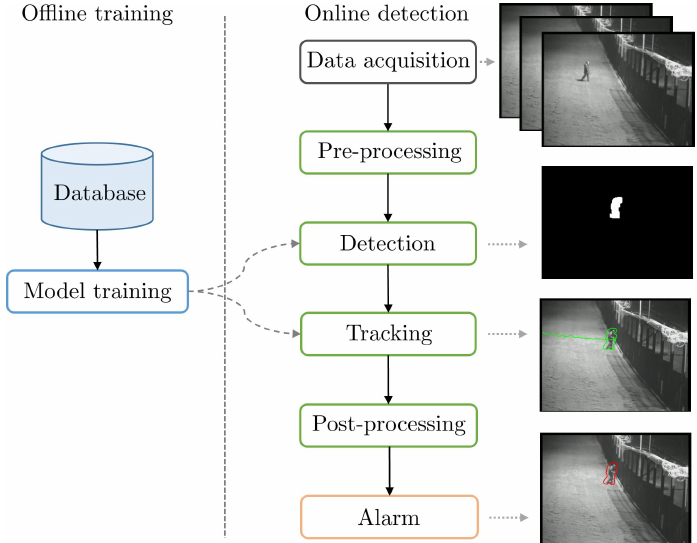
Figure 3. Typical pipeline of a PIDS, composed of an optional offline training (left part) and an online detection (middle part). An illustrative example of different steps in online detection is shown in right part of the